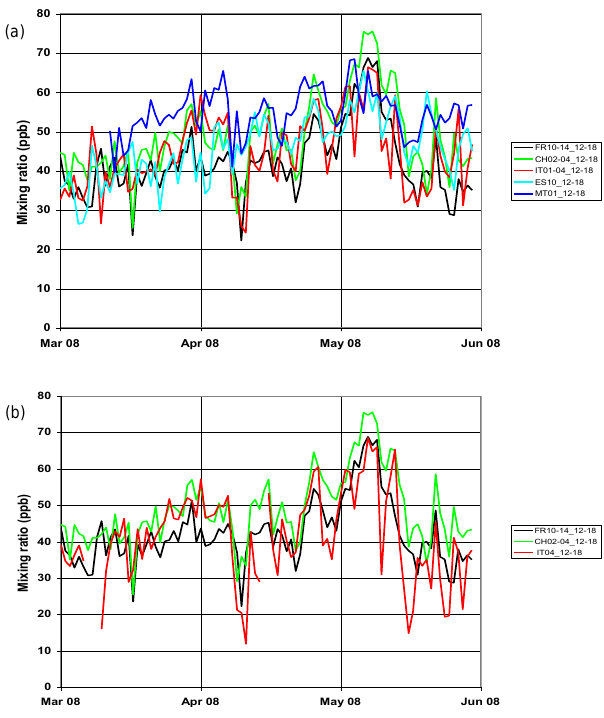
Figure 1. (a) Day-to-day variation of the 12:00–18:00 afternoon ozone (in ppb) on the EMEP stations surrounding the western Mediterranean basin for spring 2008: Spain (ES10, light blue), France (FR10-14, black), Switzerland (CH02-04, green), Italy (IT01-04, red) and Malta (MT01, blue). (b) Day-to-day variation of the 12:00–18:00 afternoon ozone (in ppb) on the EMEP stations close to the western Mediterranean basin and around the Alpine re- gion for spring 2008: France (FR10-14, black), Switzerland (CH02- 04, green) and Italy (IT04-JRC,